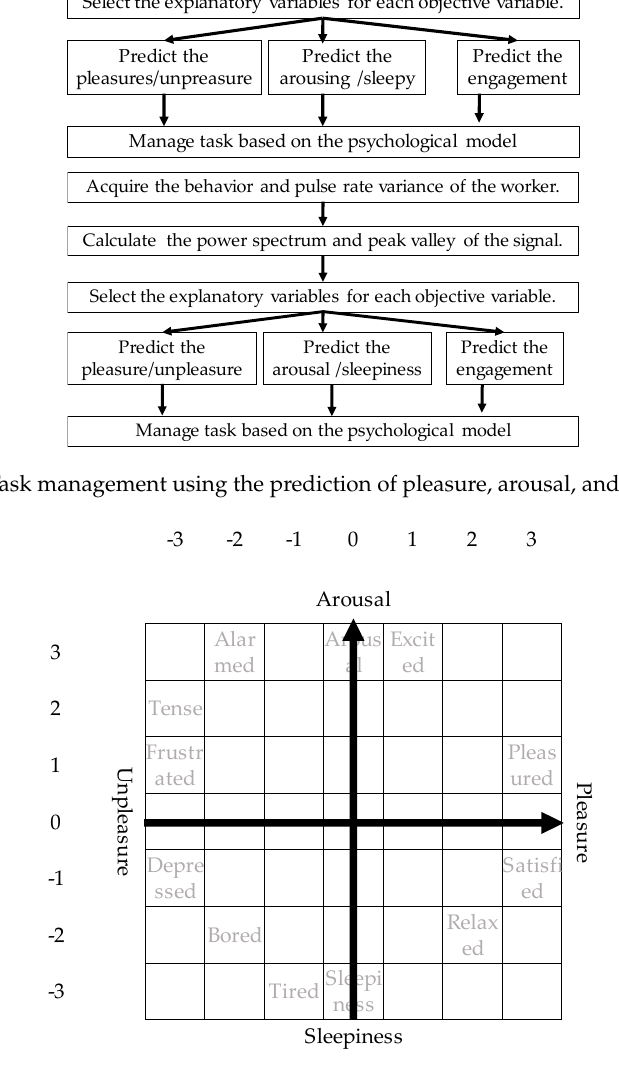
Figure 2. A questionnaire based on the circumplex model of